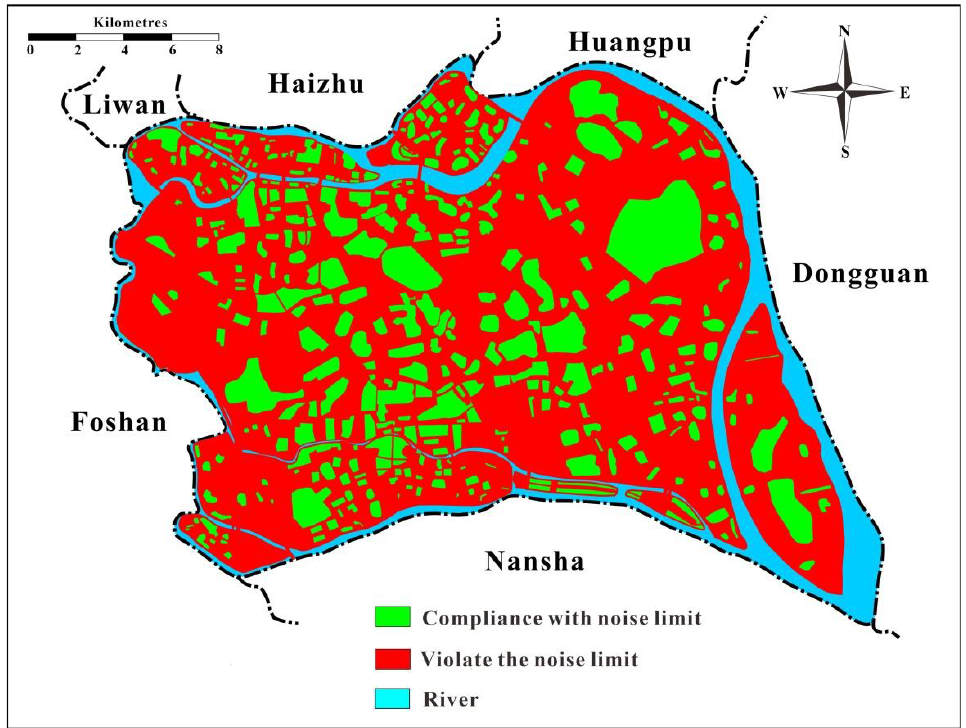
Figure 11. Nighttime noise level compliance map in Panyu District of Guangzhou City.